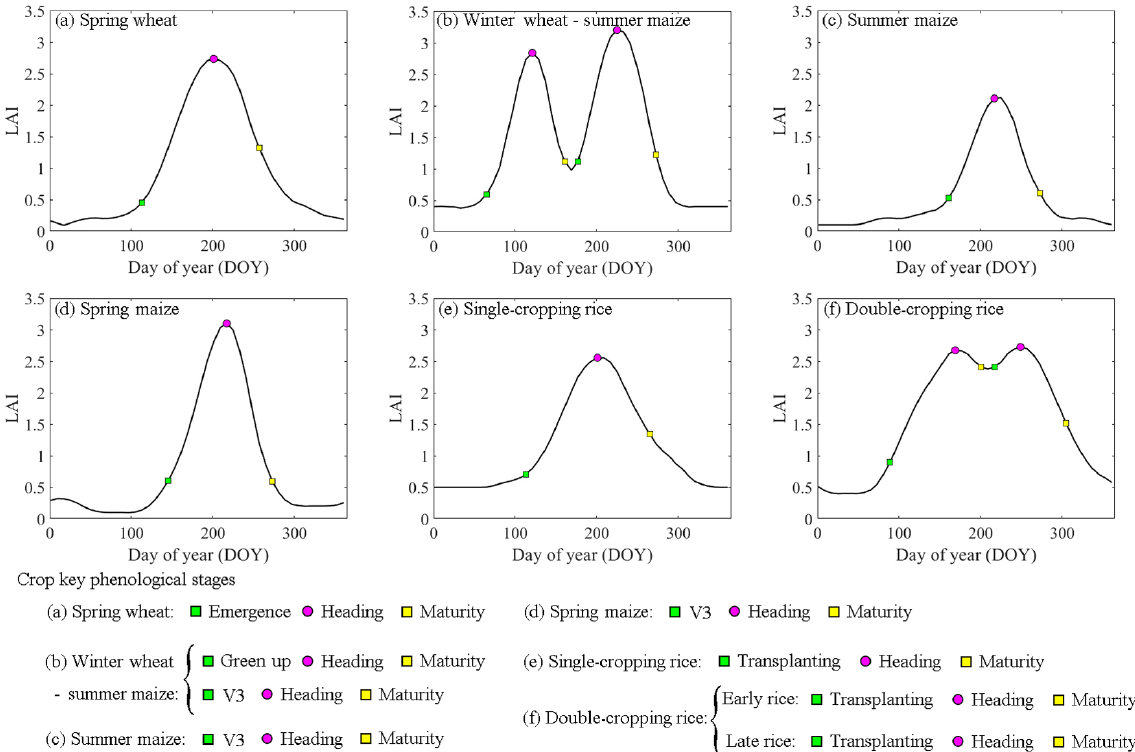
Figure 3. Typical phenological curves for different cropping systems in